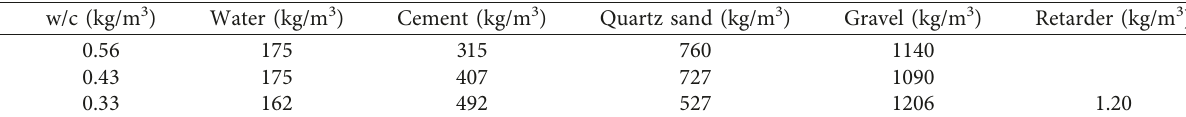
Figure 1: (a) Typical waveform and (b) typical frequency spectrum of an acoustic emission signal. Table 1: The mixed proportion of components in three different strength grades of concrete. w/c (kg/m 3 ) Water (kg/m 3 ) Cement (kg/m 3 ) Quartz sand (kg/m 3 ) Gravel (kg/m 3 ) Retarder (kg/m 3